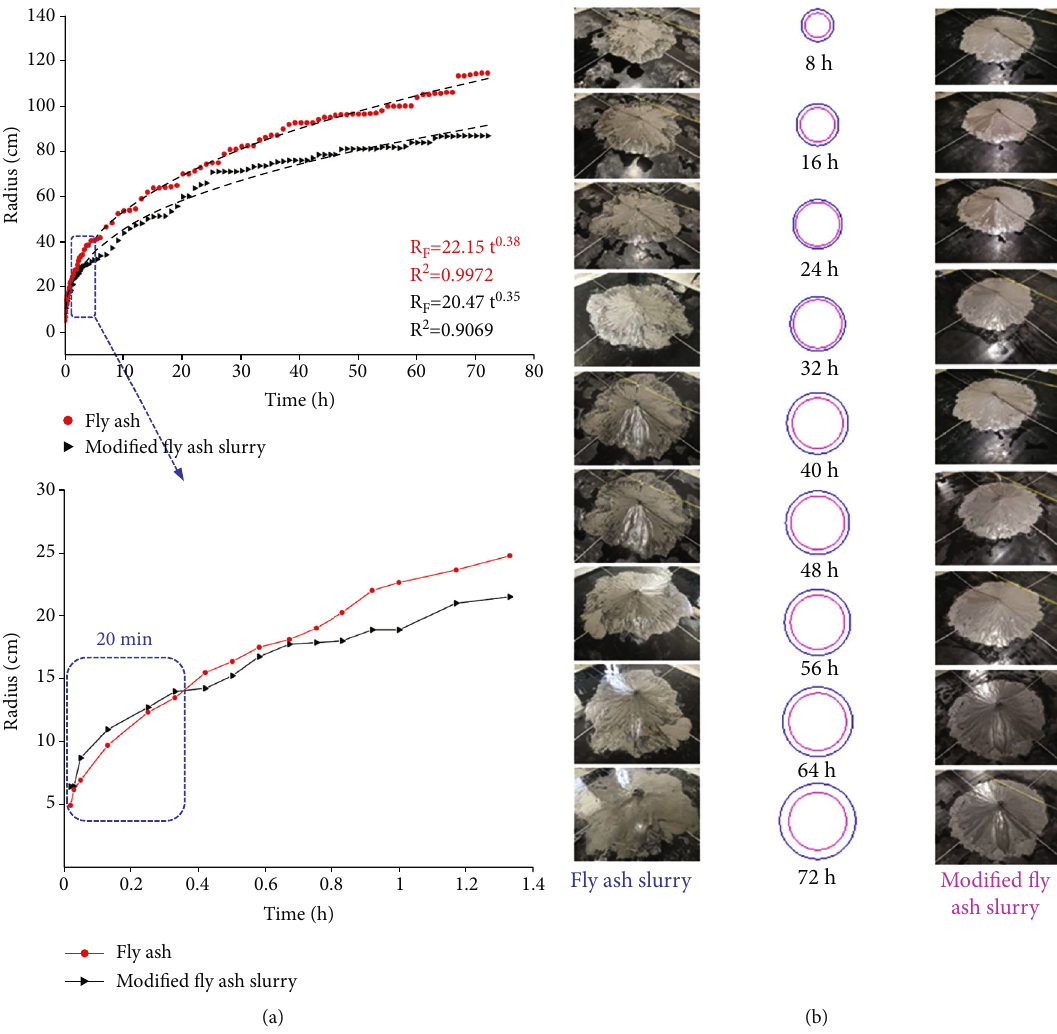
Figure 7: Di ff erence in di ff usion radius of fl y ash slurry and modi fi ed fl y ash slurry. (a) Entire process of fl y ash slurry and modi fi ed fl y ash slurry di ff usion and (b) fl y ash slurry and modi fi ed fl y ash slurry di ff usion distance and di ff usion pattern.